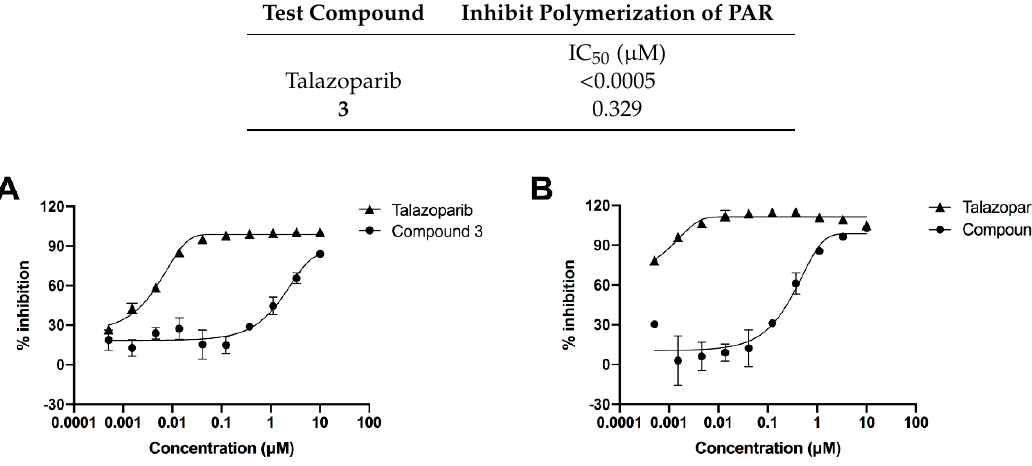
Table 1. Poly (ADP-ribose) polymerase 1 (PARP-1) enzyme inhibitory activity of Talazoparib and Table 1. Inhibitory activity of Talazoparib and compound 3 on poly (ADP-ribose) (PAR) polymerization. compound 3 . Test Compound